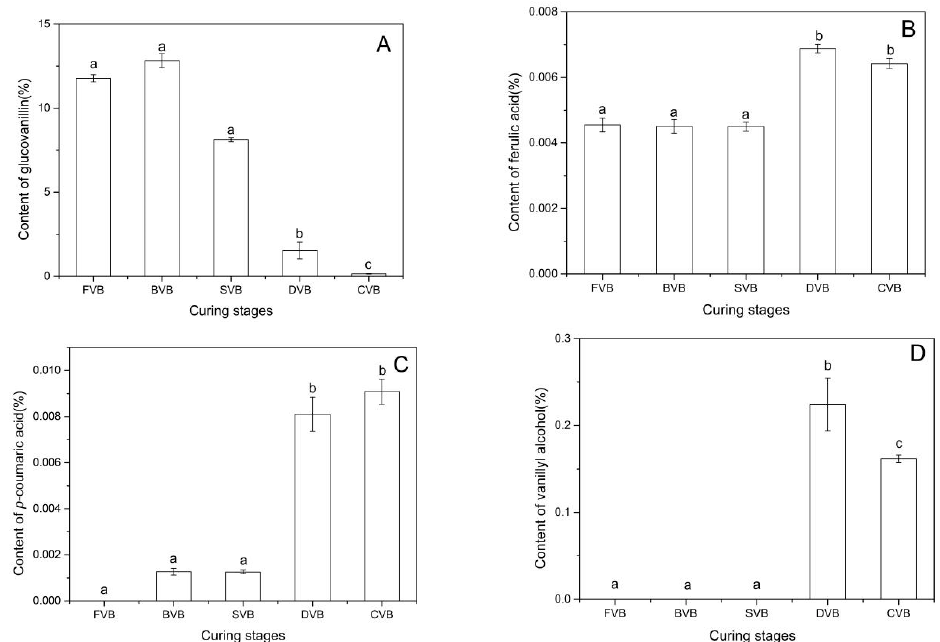
Figure 4. Amounts (% dw) of vanillin precursors in vanilla beans of the different curing stages: ( A ) Glucovanillin, ( B ) ferulic acids, ( C ) p -coumaric acid and ( D ) vanillyl alcohol. Bars represent the standard deviation of the three replicates. Data were subjected to Duncan’s test ( p < 0.05). Different letters indicate quantities that are either statistically significantly different between different stages (a,b,c,d). FVB: Fresh vanilla bean; BVB: Blanched vanilla bean; SVB: Sweating vanilla bean; DVB: Drying vanilla bean; CVB: Cured vanilla bean.